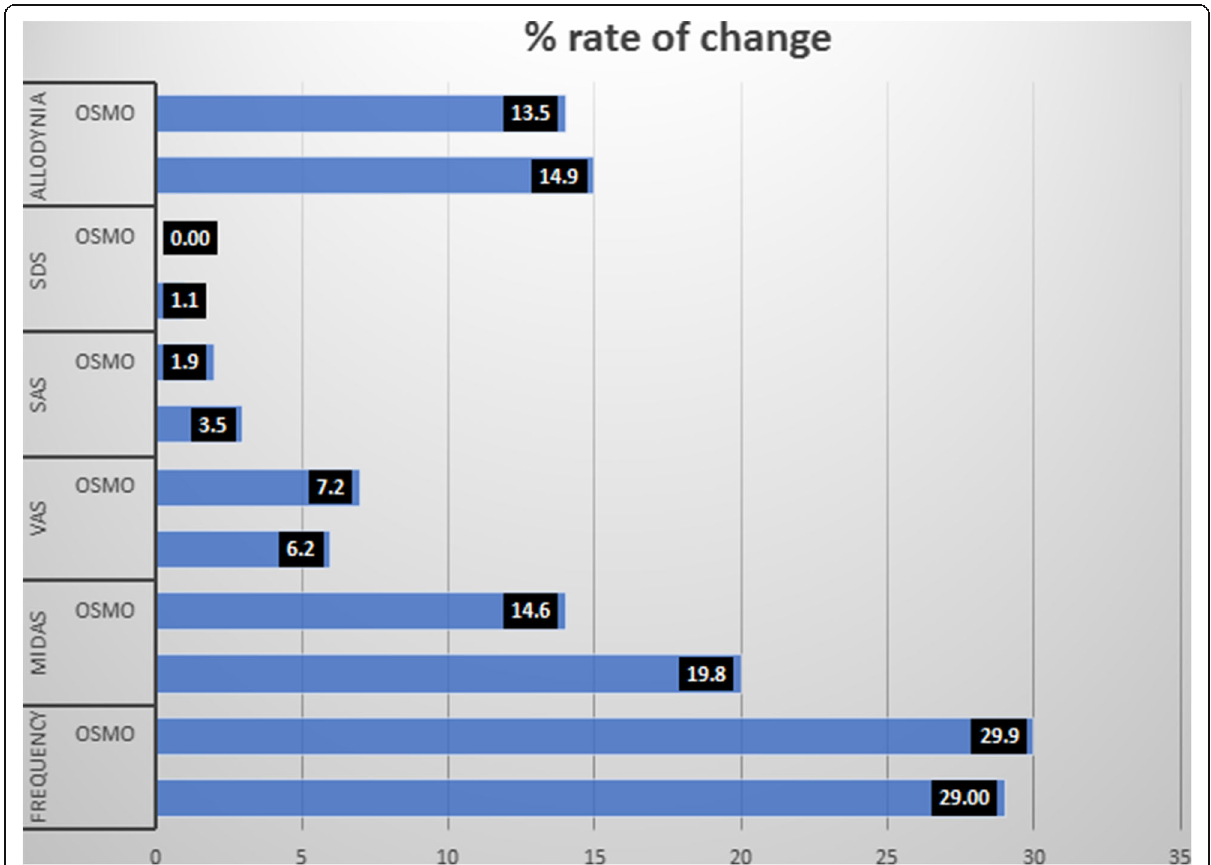
Fig. 5 Response to preventive treatments in osmophobic and non-osmophobic subjects, computed as the percent rate of monthly headache frequency